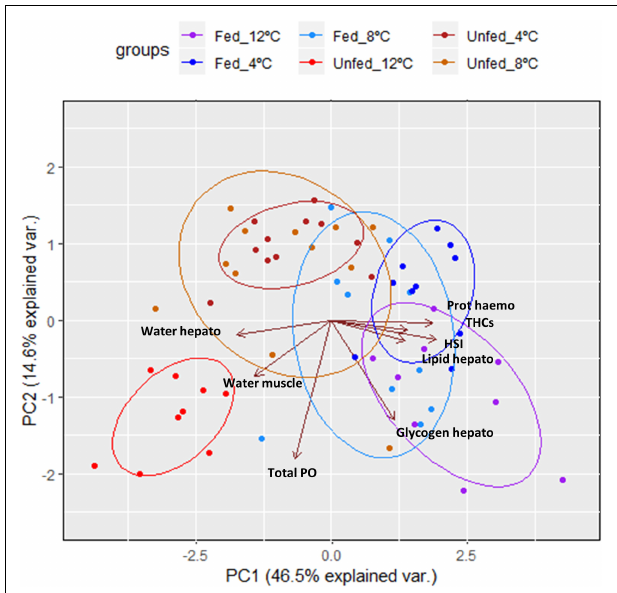
FIGURE 2 | Principal component analysis of parameters measured in the hemolymph, hepatopancreas and muscle of H. gammarus after being held for 24 weeks under different conditions ( n = 9, 12 fed; n = 9, 12 unfed; n = 10, 8 fed; n = 12, 8 unfed; n = 10, 4 fed; n = 11, 4 unfed).